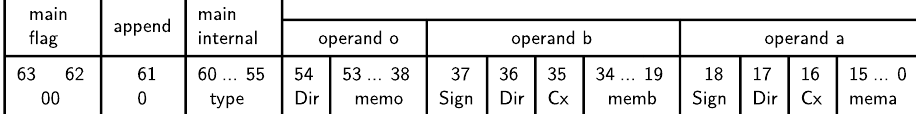
Figure 13: Main instruction template for the SIKE